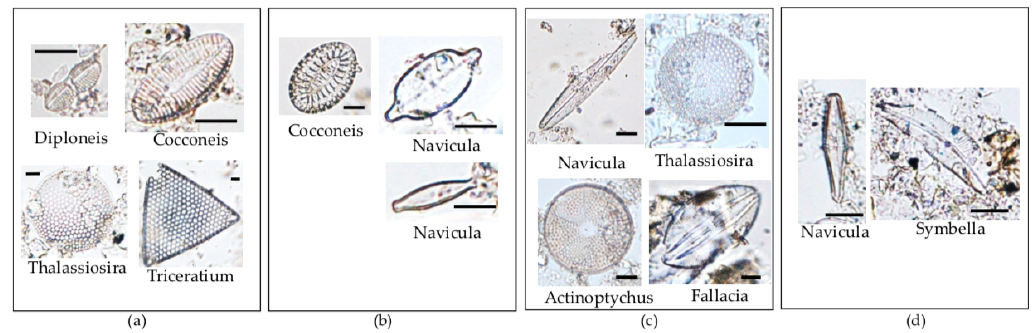
Figure 1. Microscopic observations of diatom frustules incorporated in ( a ) soil A, ( b ) soil B, ( c ) soil C, and ( d ) soil D. Each scale bar represents 20 μm.